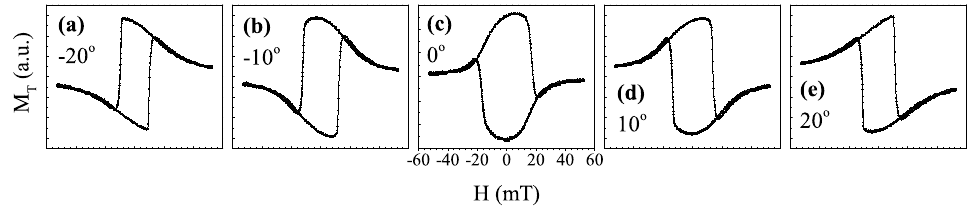
Figure 6. Panels ( a – e ) correspond to the angular dependence of M T around the TGD in the Co nanocluster assembly labeled as P3. Respective Φ values are indicated inside each